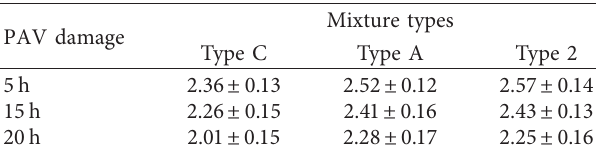
Figure 11: Healing level of unaged mixtures with moisture damage (5 FT cycles). Table 5: The initial force of aged damage asphalt mixtures